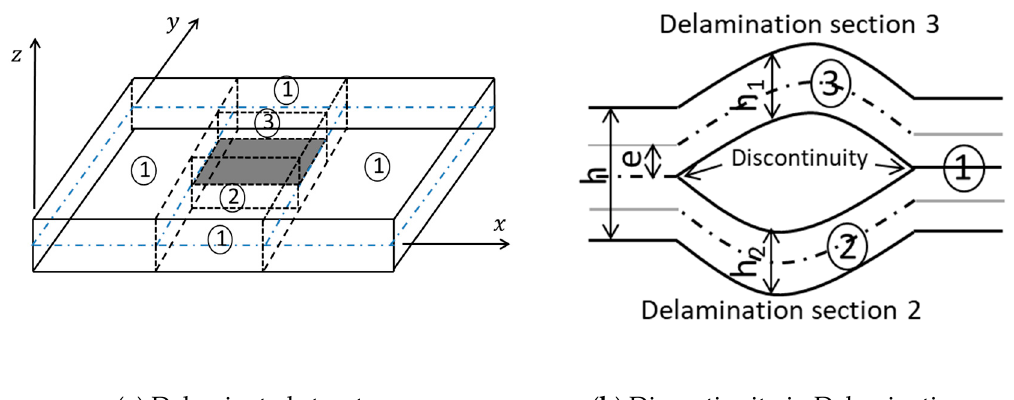
Figure 2. Geometry of laminate composite structure with center